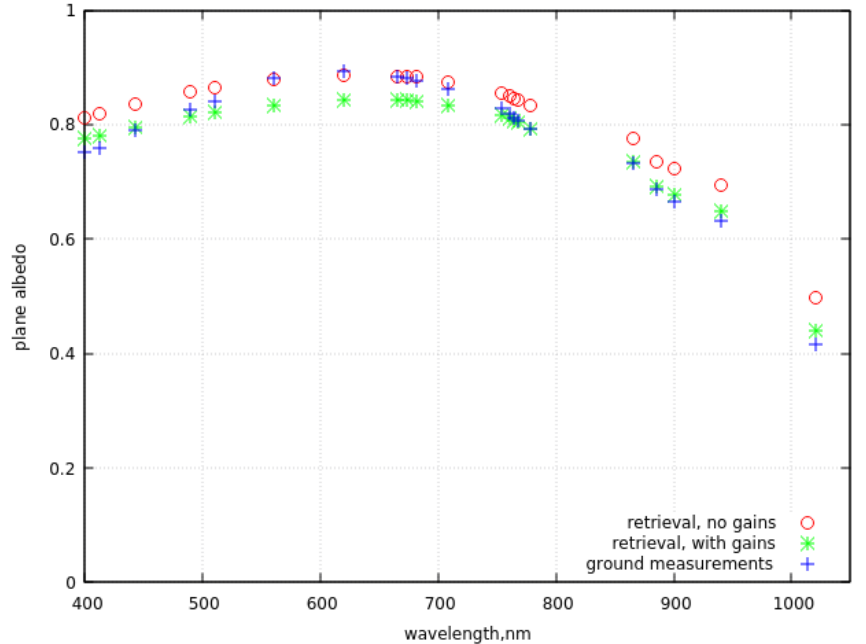
Figure 3. The plane albedo for the OLCI channels either retrieved by the updated SICE algorithm from Sentinel-3/OLCI measurements (circles, without gains, stars, with gains) and measured in situ at the Col du Lautaret site in the French Alps on 17 April 2018 (crosses, data from [48,49]). The ground measurements are corrected for the solar zenith angle (41.25 degrees) at the satellite overpass and also for the slope effects (3 degrees slope, see [7]). Table 4. The retrieved snow and pollutants parameters at two dates and two locations in European Alps. The results derived for the French Alps have been obtained using spaceborne observations. The results for the Italian Alps [45] have been derived from ground-based spectral albedo observations. The retrievals with the gains applied are given in brackets.